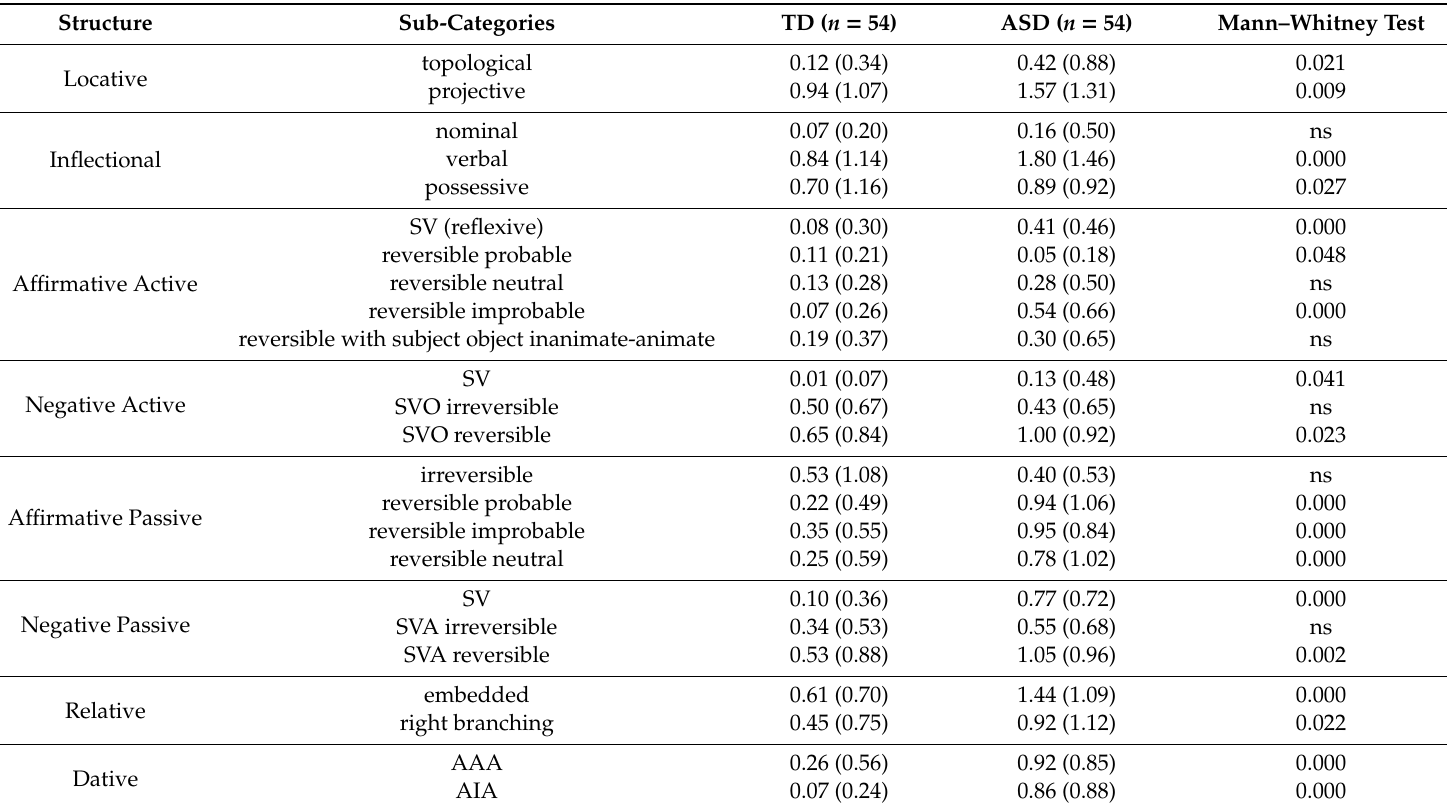
Table 3. Comparison between ASD and TD children: qualitative assessment of the clause type related subcategories.